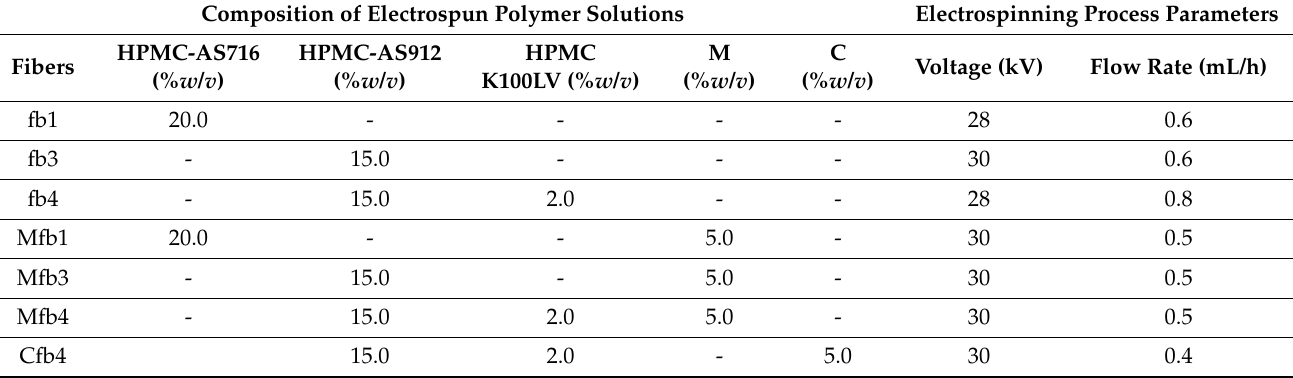
Table 1. Composition of the electrospun polymeric solutions and process parameters set up.